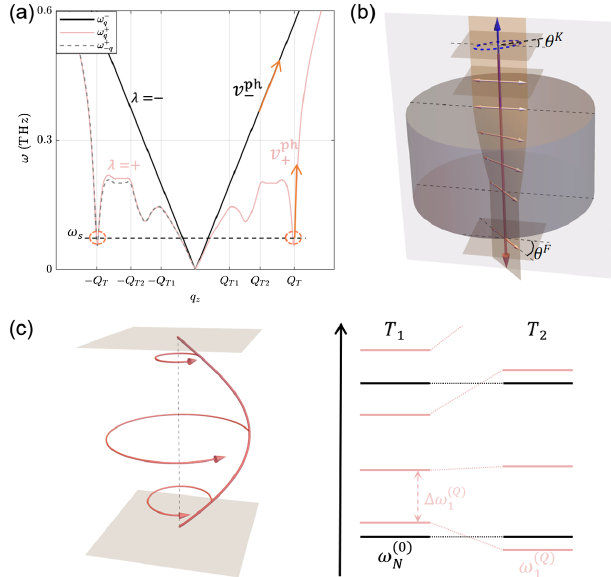
FIG. 3. Kramers-Weyl semimetals. (a) Renormalized TA pho- ≈ 1 K). Here j g =g non frequencies at T ¼ 1 . 1 K (near T c T z 0 j ¼ 1 . 43 × 10 − 4 and the group speeds of left-handed (pink) and right- . ω is the frequency handed (black) chiral TA phonons are v ph s (cid:2) of standing acoustic waves. (b) Magnetoacoustic effects. The gyromagnetic acoustic medium (cylinder in gray) is surrounded by regular medium. When a linearly polarized (two-headed arrow denotes the polarization direction) TA wave (red arrow) travels to the interface normally, the reflected wave (blue) becomes elliptical with Kerr ellipticity ϵ K and rotation angle θ K , while the polarization plane of refracted wave (red) gradually rotates by Faraday angle θ F when it moves forward. (c) Left: schematics of left-handed chiral standing acoustic wave between two nodes. The red line denotes the amplitude of each center of mass and the arrows refer to its anticlockwise rotating trajectory. Right: resonant frequencies of standing modes. Given a finite length system at T 1 ¼ 1 . 1 K, the frequencies of chiral standing modes Δ ω ð Q T Þ with wave vector near Q are ω n , and of normal long T Q T þ 0 Þ 0 Þ . ω ð is the N th wavelength standing modes (black) are ω ð N n 0 normal standing mode close to ω ð Q T Þ 1 . When the system is cooled 0 Þ down from T 1 to T 2 ( ∼ 0 . 02 K), the frequencies of ω ð n are almost the same, while the fundamental chiral mode ω decreases Q T rapidly and the frequency differences Δ ω ð Q T Þ n